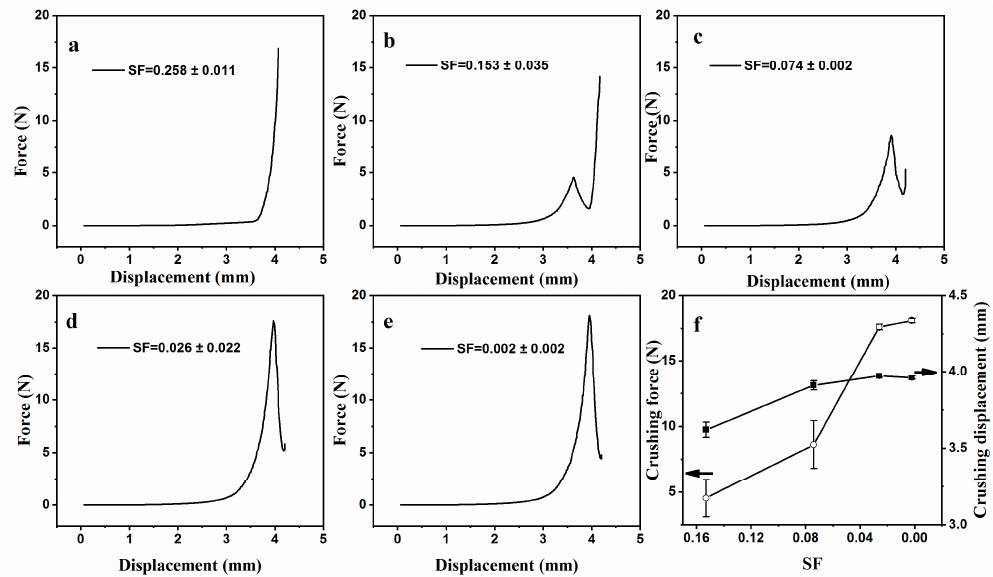
Figure 9. The effect of SF on the mechanical properties of mm-CaSA-Caps. The concentrations of CMC were 0.75 ( a ), 1.0 ( b ), 1.15 ( c ), 1.25 ( d ) and 1.5 ( e ) wt.%. The crushing force and the crushing displacement of the Caps with different SF ( f ). The concentration of SA was 0.75 wt.%. The concentration of CaCl 2 was 1.5 wt.%.